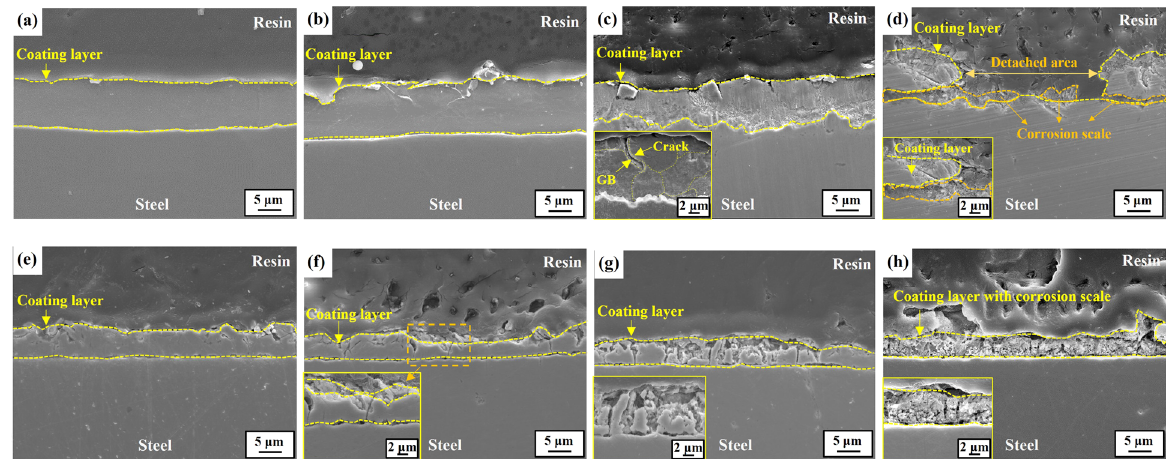
Fig. 9 Change in the cross-section morphologies with increasing immersion times. a – d GI-coated steel. e – h GA-coated steel. a , e three h. b , f 24 h. c, g 72 h. d, h 168 h.